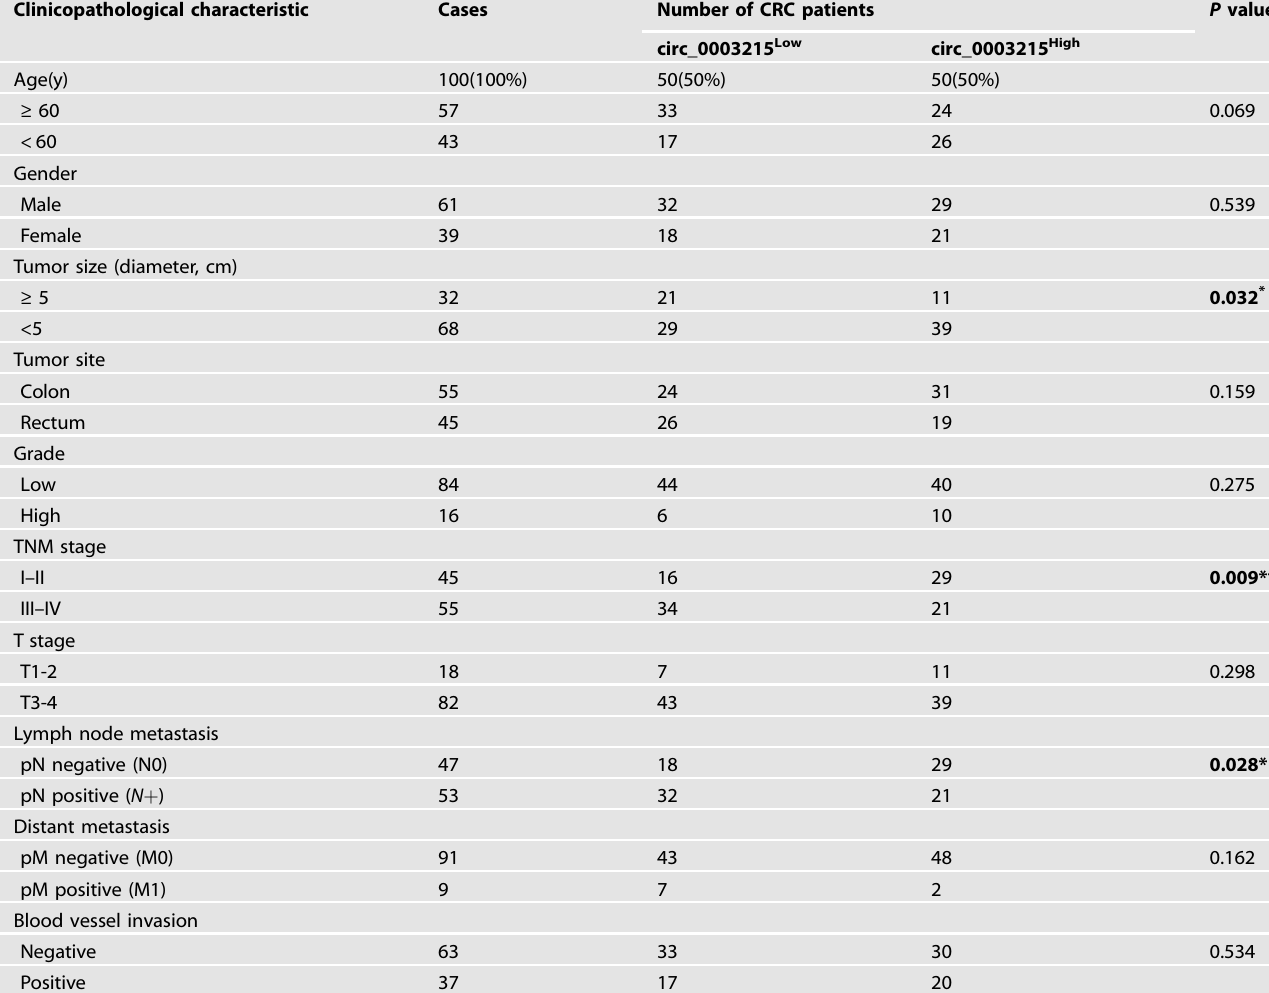
Table 1. Correlations between the expression of circ_0003215 and various clinicopathological characteristics of 100 CRC patients. Clinicopathological characteristic